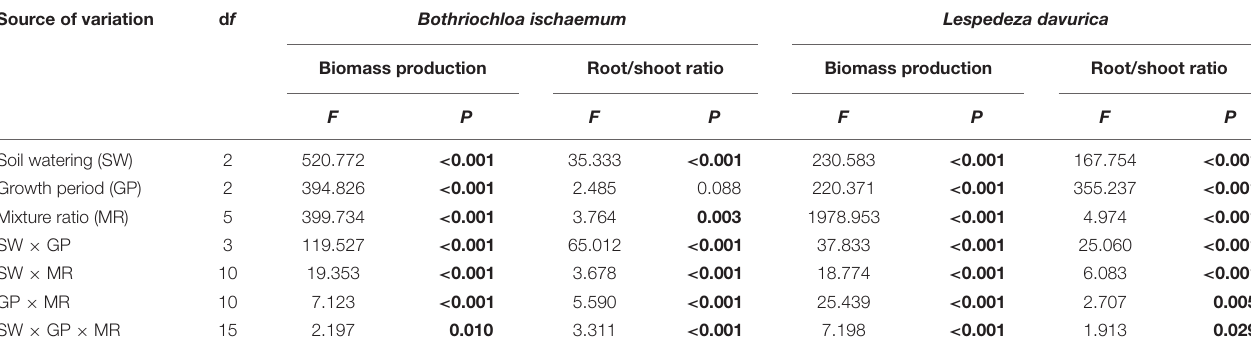
TABLE 2 | Effects of soil watering, growth period, mixture ratio, and their interaction in the three-way ANOVA on the biomass production and root/shoot ratio (RSR) of both species. Source of variation d f Bothriochloa ischaemum Lespedeza